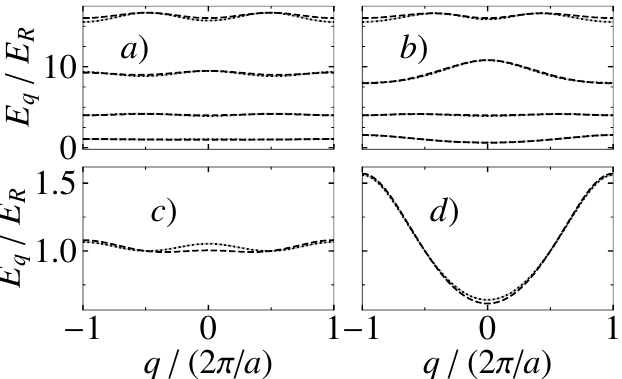
Figure 5: Top row: first 4 energy bands, bottom row: first energy band for ∆ = 0, ε = Ω / Ω = 0.1, a),c) α = 0 and b),d) α = π/ 4. Gray lines are obtained by diag- p c onalizing the full Hamiltonian (7), dotted lines in the same way from the adiabatic Hamiltonian (18), and dashed lines are evaluated from the scattering problem